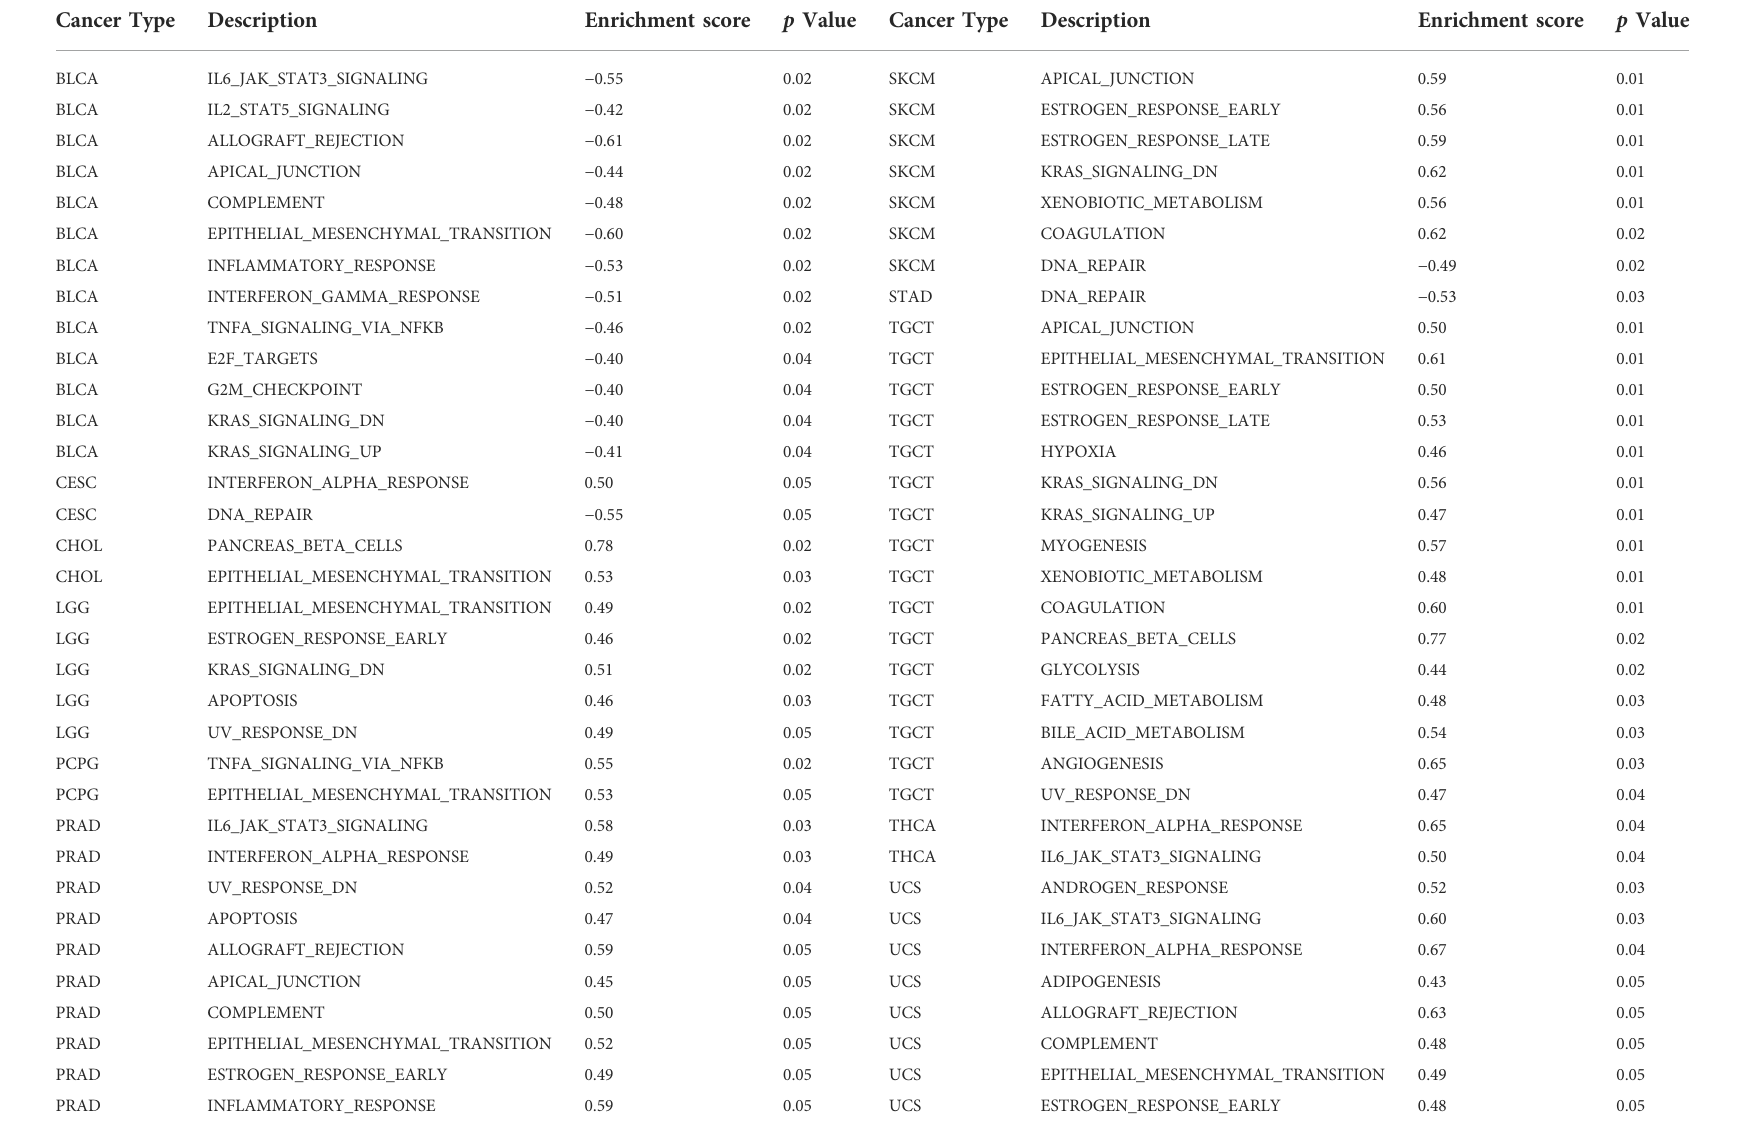
TABLE 1 Association of forkhead box Q1 expression with cancer-related